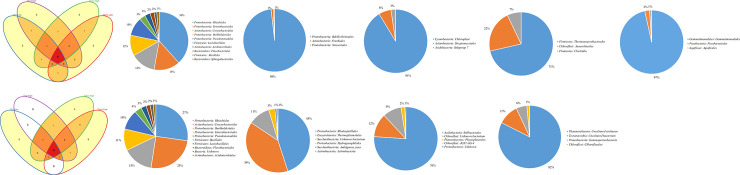
a-f. Shared and unique prokaryotic taxa in 16S rRNA cDNA at Chuka. The Venn diagram (4a) show number of shared and unique taxa at order level within farming systems. The pie diagrams (4b - 4f) show most abundant and unique taxa at order level across farming systems. g-k. Shared and unique prokaryotic taxa in 16S rRNA cDNA at Chuka. The Venn diagram (4g) show number of shared and unique taxa at order level within farming systems. The pie diagrams (4h - k) show most abundant and unique taxa at order level across farming systems.